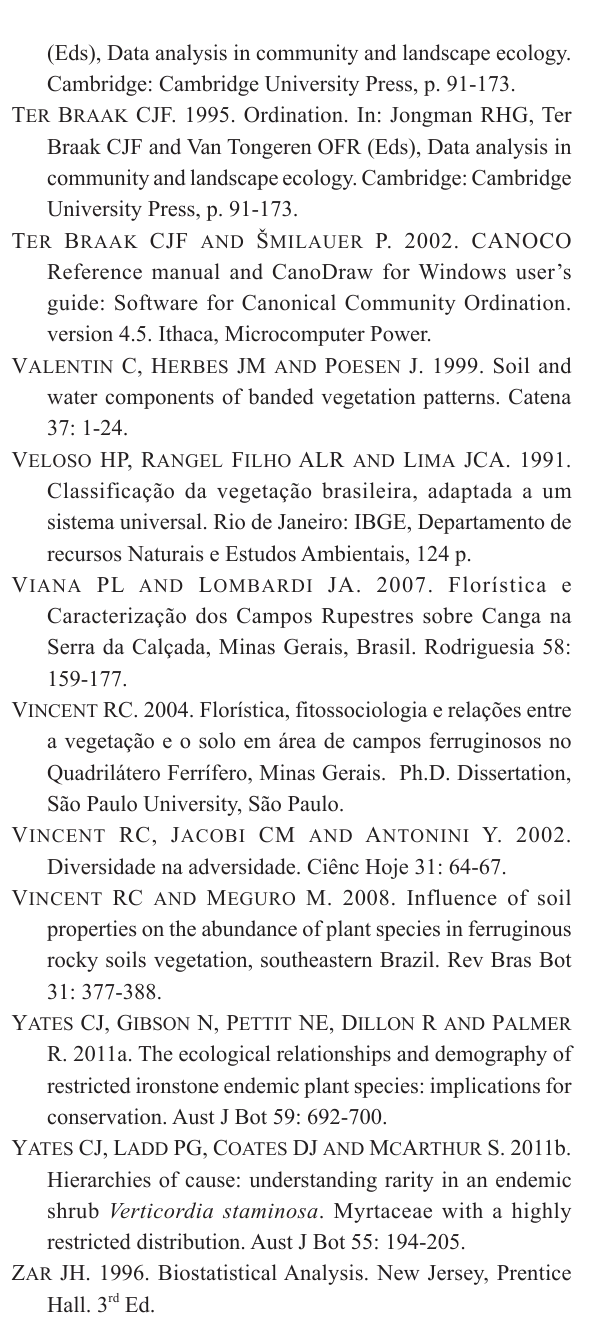
TABLE SI - Total density of plant species recorded in each vegetation type at Serra Sul, Serra dos Carajás, Pará State, Brazil. HCR = herbaceous campo rupestre; SCR = shrubby campo rupestre; CF = capão forest; MF = montane